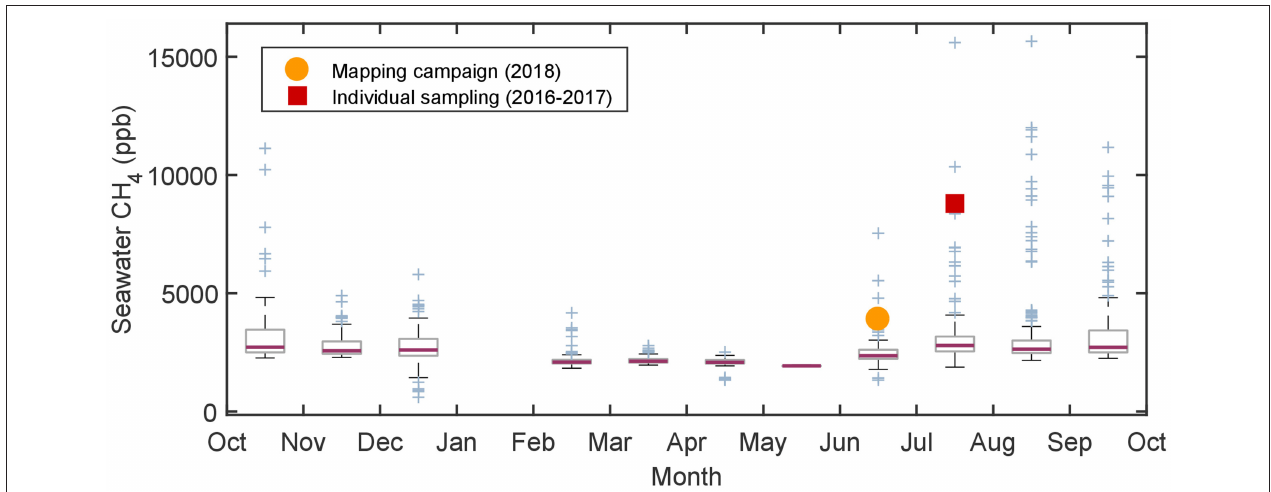
FIGURE 5 | Boxplots representing the annual cycle of seawater CH 4 mole fractions in the Gotland Basin from the MEMENTO database. The yellow dot is the average value from the mapping campaign, and the red square is the mean value from the individual samplings. In the boxplots, the median value is represented by the purple line, the 25th and 75th percentiles indicated by the gray boxes, and outliers are marked as blue crosses.